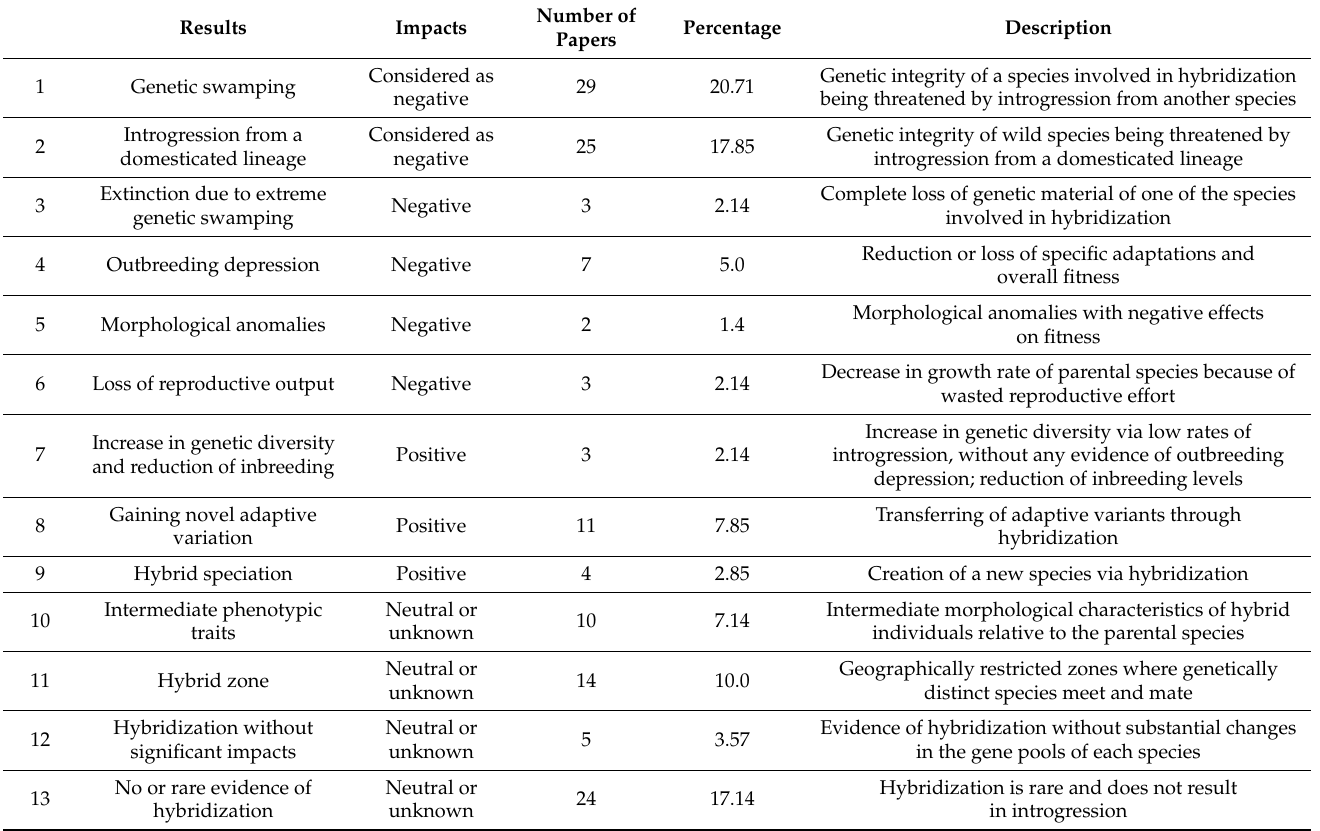
Table 1. Outcomes of hybridization described in papers included in the systematic review. The outcomes are grouped by the character of their impact. The reported frequencies of different hy- bridization outcomes in the papers studied should not be considered as reliable estimates of the real